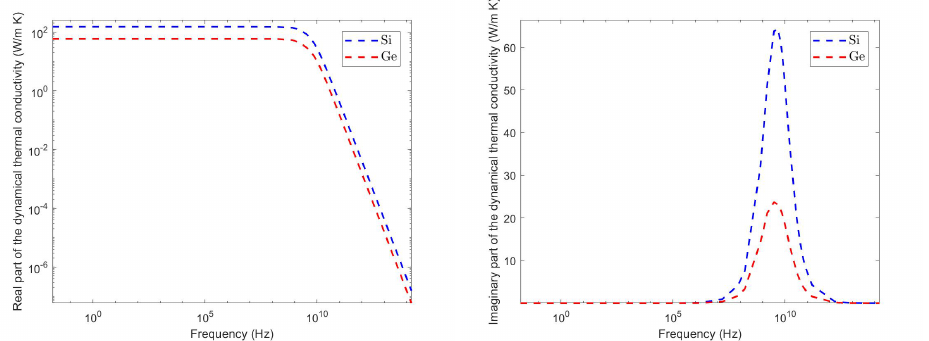
Figure 3. ( Left ): Real part of the dynamical thermal conductivity vs. frequency f . ( Right ): Imaginary part of the dynamical thermal conductivity vs. f . T = 300 K.